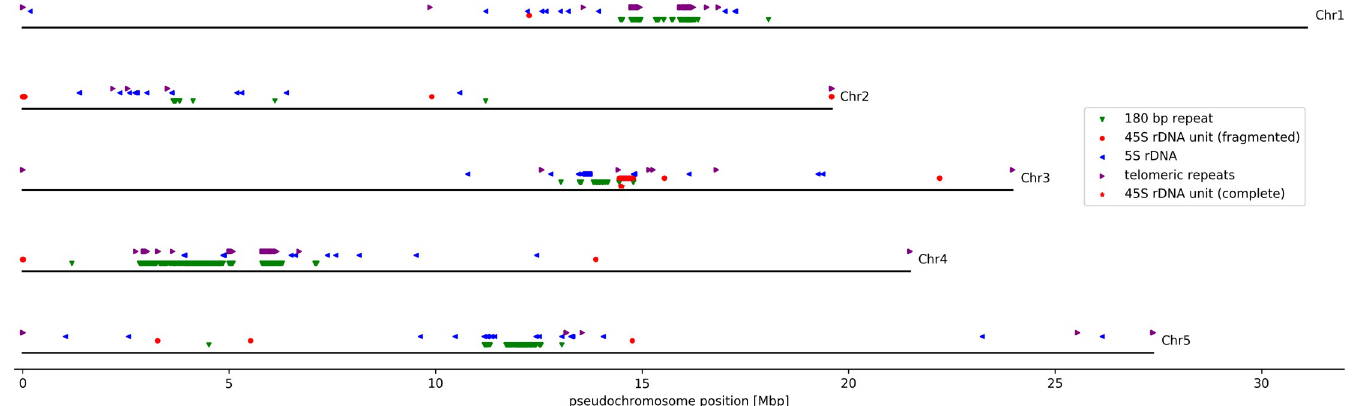
Fig 1. Nd-1 genome structure. Schematic pseudochromosomes are represented by black lines with positions of genomics features highlighted with colored icons as indicated in the insert.